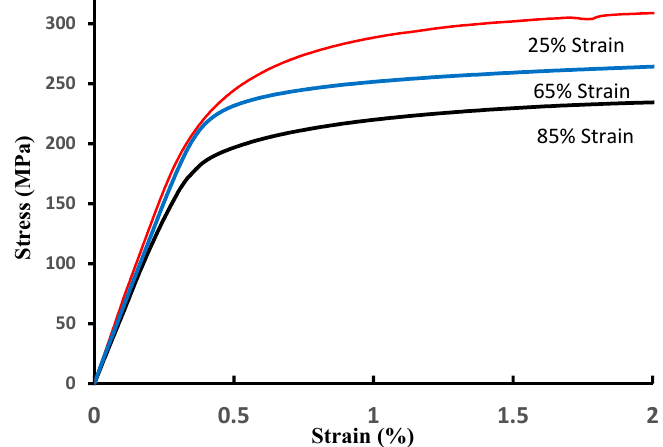
Figure 8. Stress/strain behavior of the wrought Al 6061-T6 samples after 90 days of B-117 salt fog exposure.